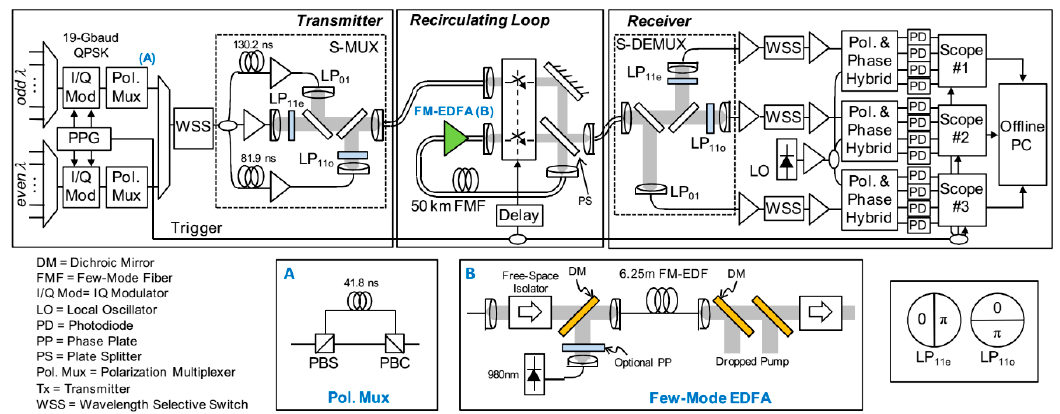
Figure 13. Experiment setup for a few-mode fiber (FMF) loop experiment.